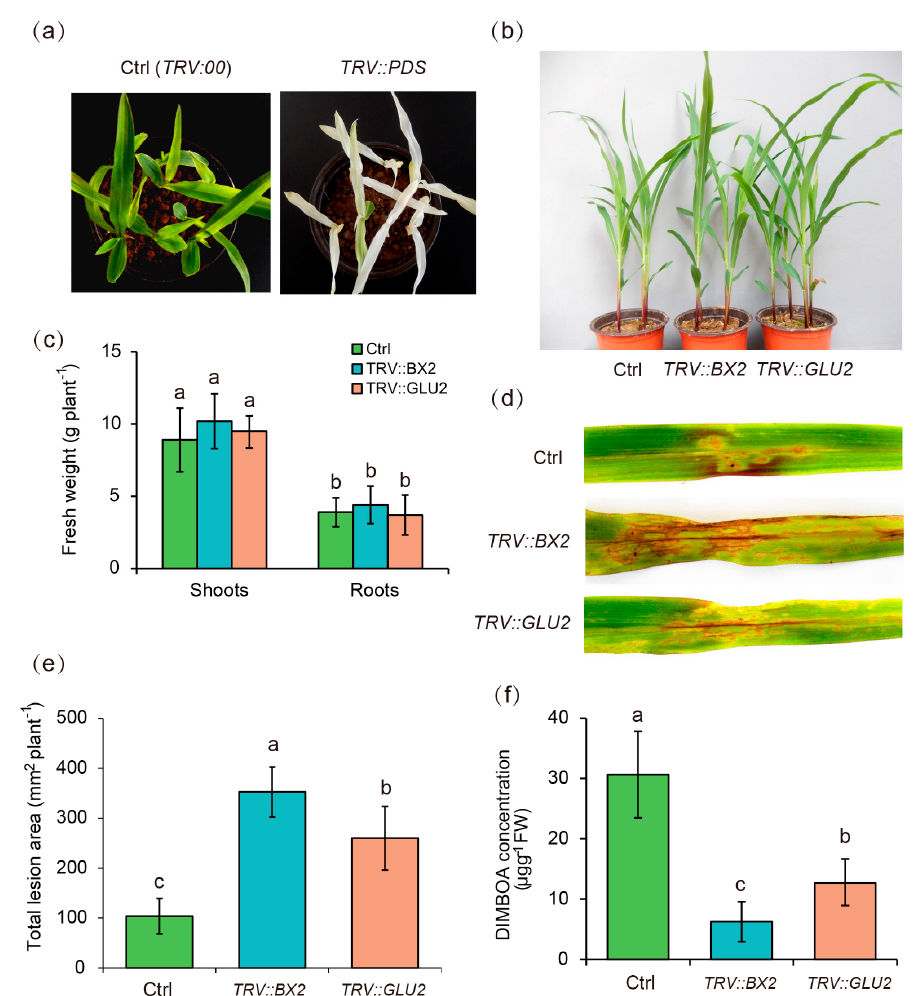
Figure 4. Virus-mediated silencing of BX2 and GLU2 attenuated the P. fluorescens MZ05-induced disease resistance in maize plants . ( a ) The phenotype of maize plants infected with TRV::00 (Ctrl) or TRV::PDS at two weeks. ( b ) Maize plants were initially infected with TRV::00 (Ctrl), TRV::BX2 , or TRV::GLU2 for four weeks, and ( c ) shoot and root fresh weights were measured in these plants. Subsequently, these plants were inoculated with P. fluorescens MZ05 (1 × 10 8 CFU/g soil) for 7 days. After that, the inoculated plants were sprayed with a spore suspension of S. turcica at 5 × 10 4 conidia mL -1 for 5 days. Then, these plants were used to analyze disease symptoms ( d ), total lesion area ( e ), and DIMBOA content ( f ). Different letters indicate statistically significant differences between the non-inoculated and inoculated plants as analyzed by Ducan’s tests ( p < 0.05).